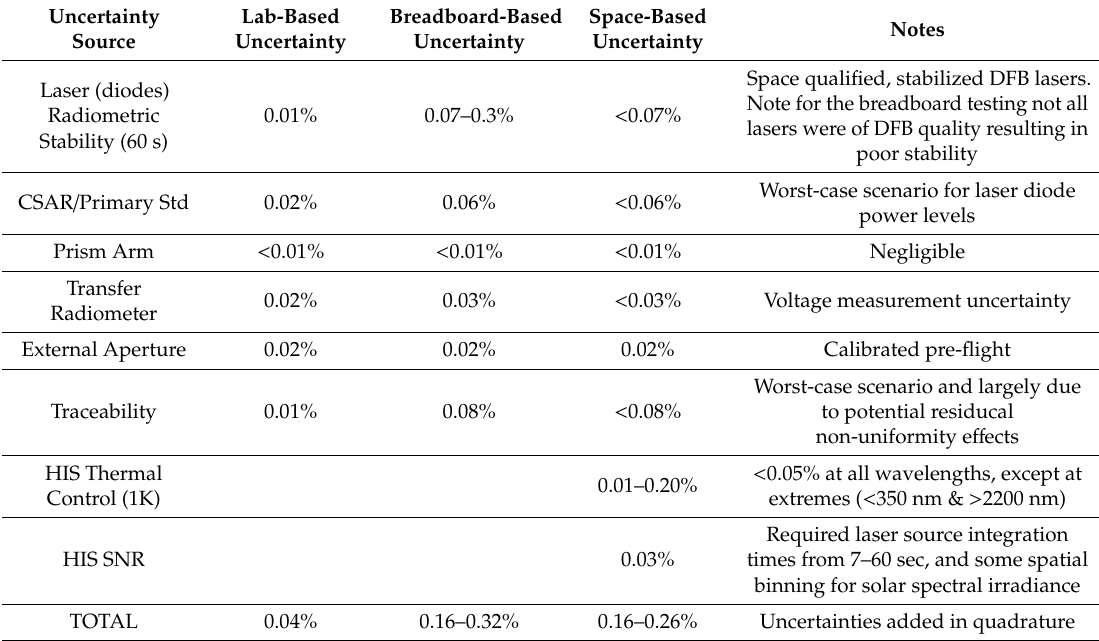
Table 9. Calibration system and HIS radiometric uncertainty (k =